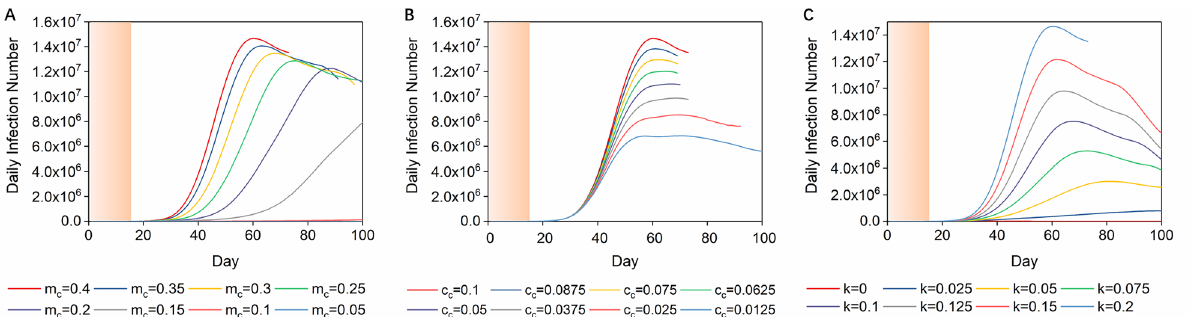
Figure 3. Impact of single interventions on daily infection curves. ( A ) Daily infection curves for the UK with intraregional growth rates varying from 0.4 to 0.05. The orange section means no interventions were taken. ( B ) Daily infection curves for the UK with interregional communication rates varying from 0.1 to 0.0125. ( C ) Daily infection curves for the UK with detection rates of infectors varying from 0 to